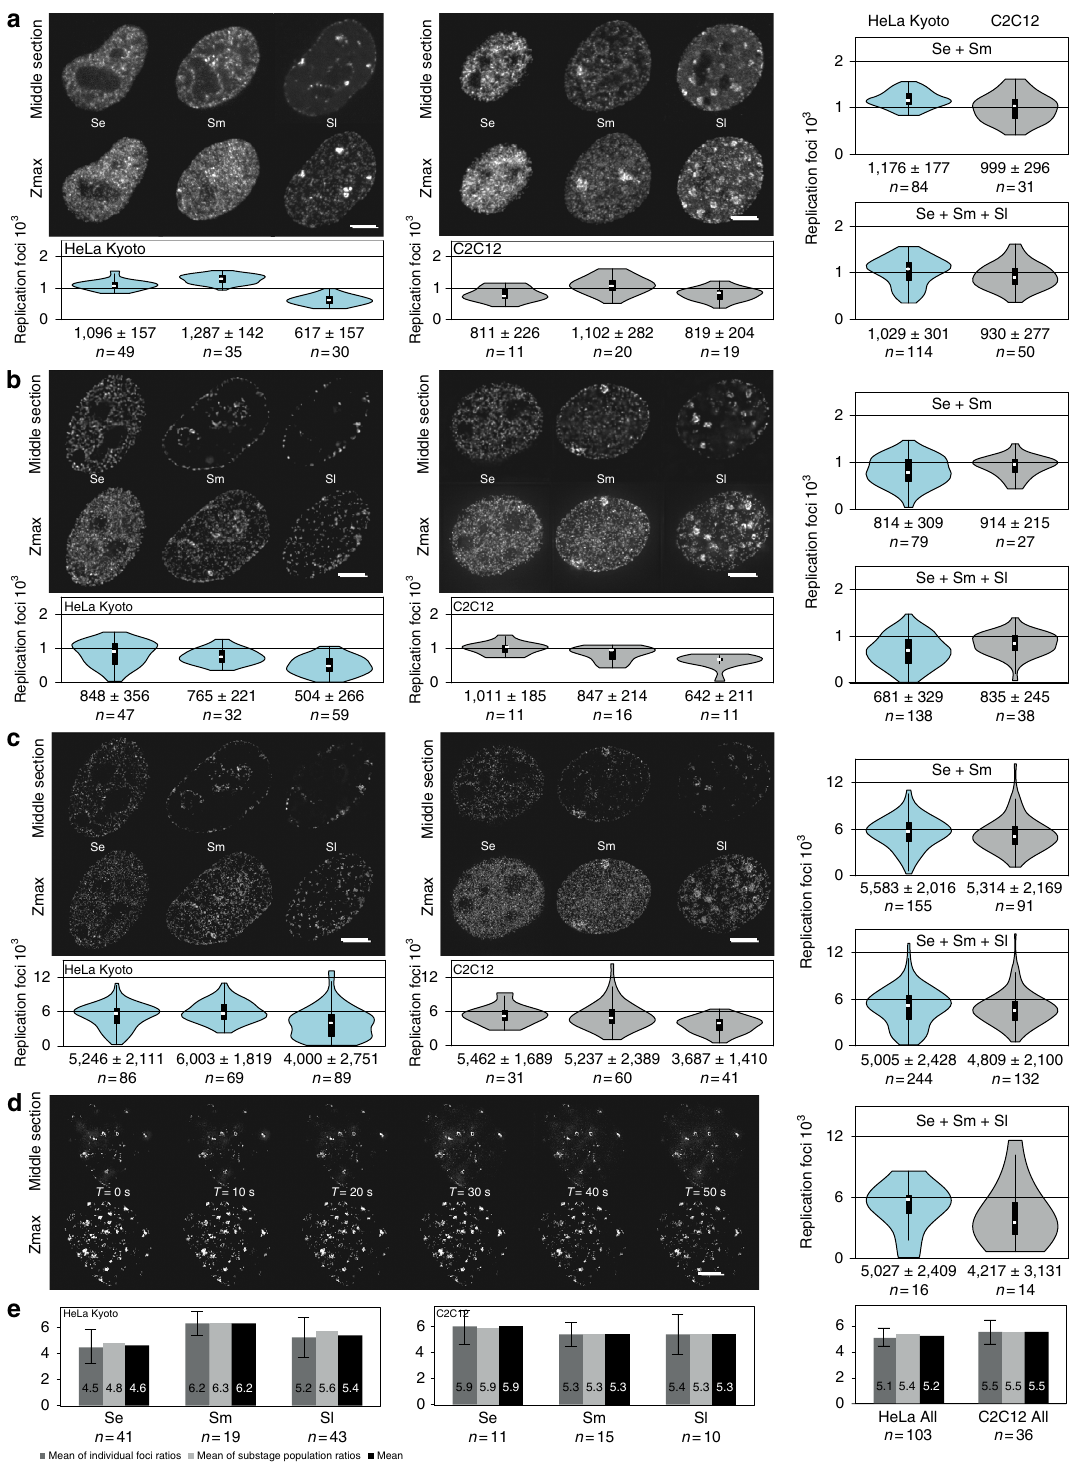
Mean of individual foci ratios Mean of substage population ratios Mean Figure 3 | 3D quantification of RFi numbers throughout S-phase. ( a ) Mid sections and maximum intensity z-projections (Zmax) of spinning disk confocal microscopy images of human (HeLa Kyoto) and mouse (C2C12) cells as indicated representative of the three major S-phase patterns—early (Se), mid (Sm) and late (Sl)—are shown. Scale bar, 5 m m. Numbers (mean ± s.d.; summary of the data in Supplementary Fig. 5 and Supplementary Table 1) of nuclear RFi quantified as described in Supplementary Fig. 3 are plotted separately for each of the three major S-phase patterns as well as the pooled data for Se and Sm and the whole S-phase. N indicates the number of cells analysed. ( b ) As in a representative images from wide-field deconvolution microscopy and corresponding RFi numbers. Scale bar, 5 m m. ( c ) As in a representative images from 3D-SIM and corresponding RFi numbers. Scale bar, 5 m m. ( d ) Time series (see also Supplementary Movie 2) of live mouse cells imaged using 3D-SIM and corresponding RFi numbers for mouse and also for human cells. Scale bar, 5 m m. ( e ) Histogram of RFi ratios from super-resolution versus conventional microscopy. Ratios were calculated either per individual cell (dark grey) or from all cells pooled (light grey). In addition, both data sets were combined (black). Given error bars represent the s.d.